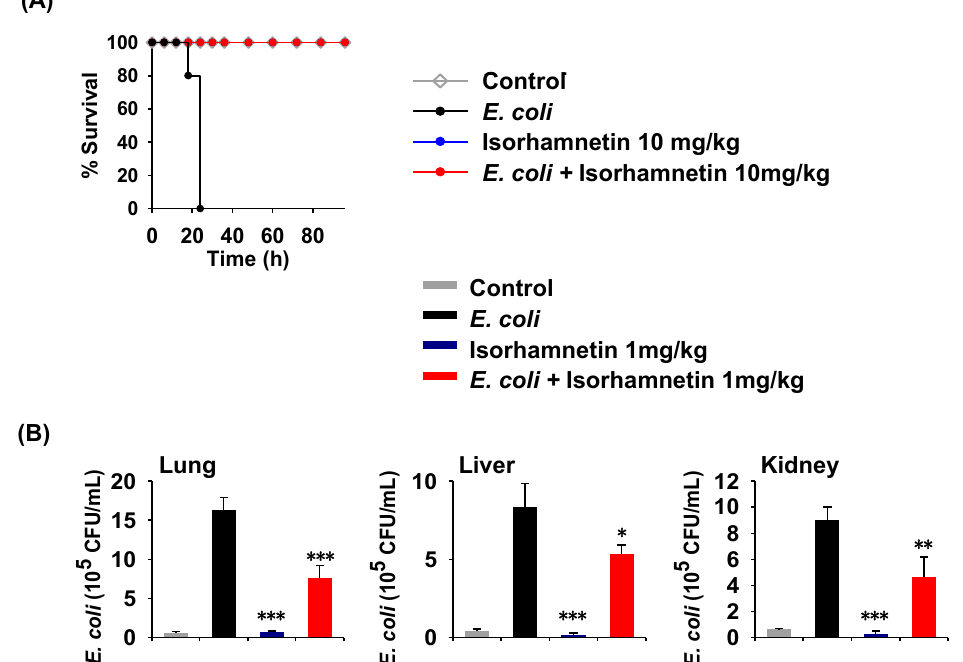
Figure 2. In vivo examination of the effects of isorhamnetin on Escherichia coli -induced sepsis. ( A ) Potential of this compound to promote the survival of mice in response to E. coli -induced sepsis. ( B ) Evaluation of the bacterial load in the visceral organs of mice. Data are presented as the means ± standard error of the mean (SEM). * p < 0.05; ** p < 0.01; *** p < 0.001 compared to the E. coli group.